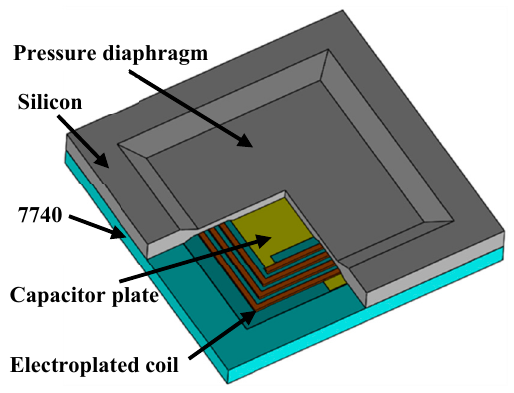
Figure 1. Structure of the passive pressure sensor. Table 1. The feature sizes of the coil.